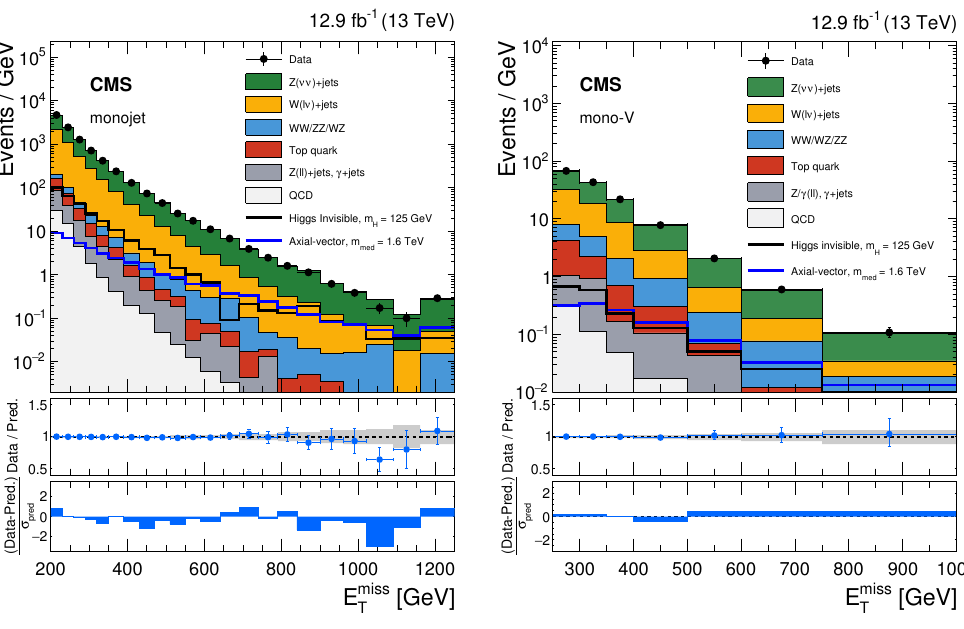
Figure 7 . Observed E miss distribution in the monojet (left) and mono-V (right) signal regions T compared with the background expectations for various SM processes evaluated after performing a combined (cid:12)t to the data in all the control samples, as well as in the signal region. The (cid:12)t is performed assuming the absence of any signal. The last bin includes all events with E miss > 1160 T (750) GeV for the monojet (mono-V) category. Expected signal distributions for a 125 GeV Higgs boson decaying exclusively to invisible particles, and for a 1.6 TeV axial-vector mediator decaying to 1 GeV DM particles, are overlaid. The ratio of data and the post-(cid:12)t background prediction is shown for both the monojet and mono-V signal regions. The gray bands in these ratio plots indicate the post-(cid:12)t uncertainty in the background prediction. Finally, the distributions of the pulls, de(cid:12)ned as the di(cid:11)erence between data and the post-(cid:12)t background prediction relative to the post-(cid:12)t uncertainty in the prediction, are also shown in the lower